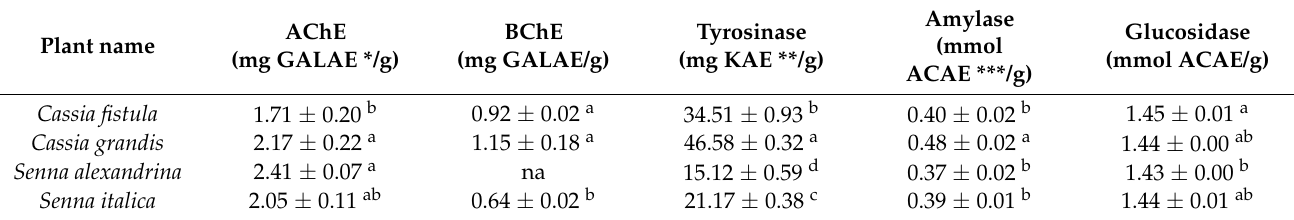
Table 4. Enzyme inhibitory activity of leaf methanolic extracts of the Cassia and Senna